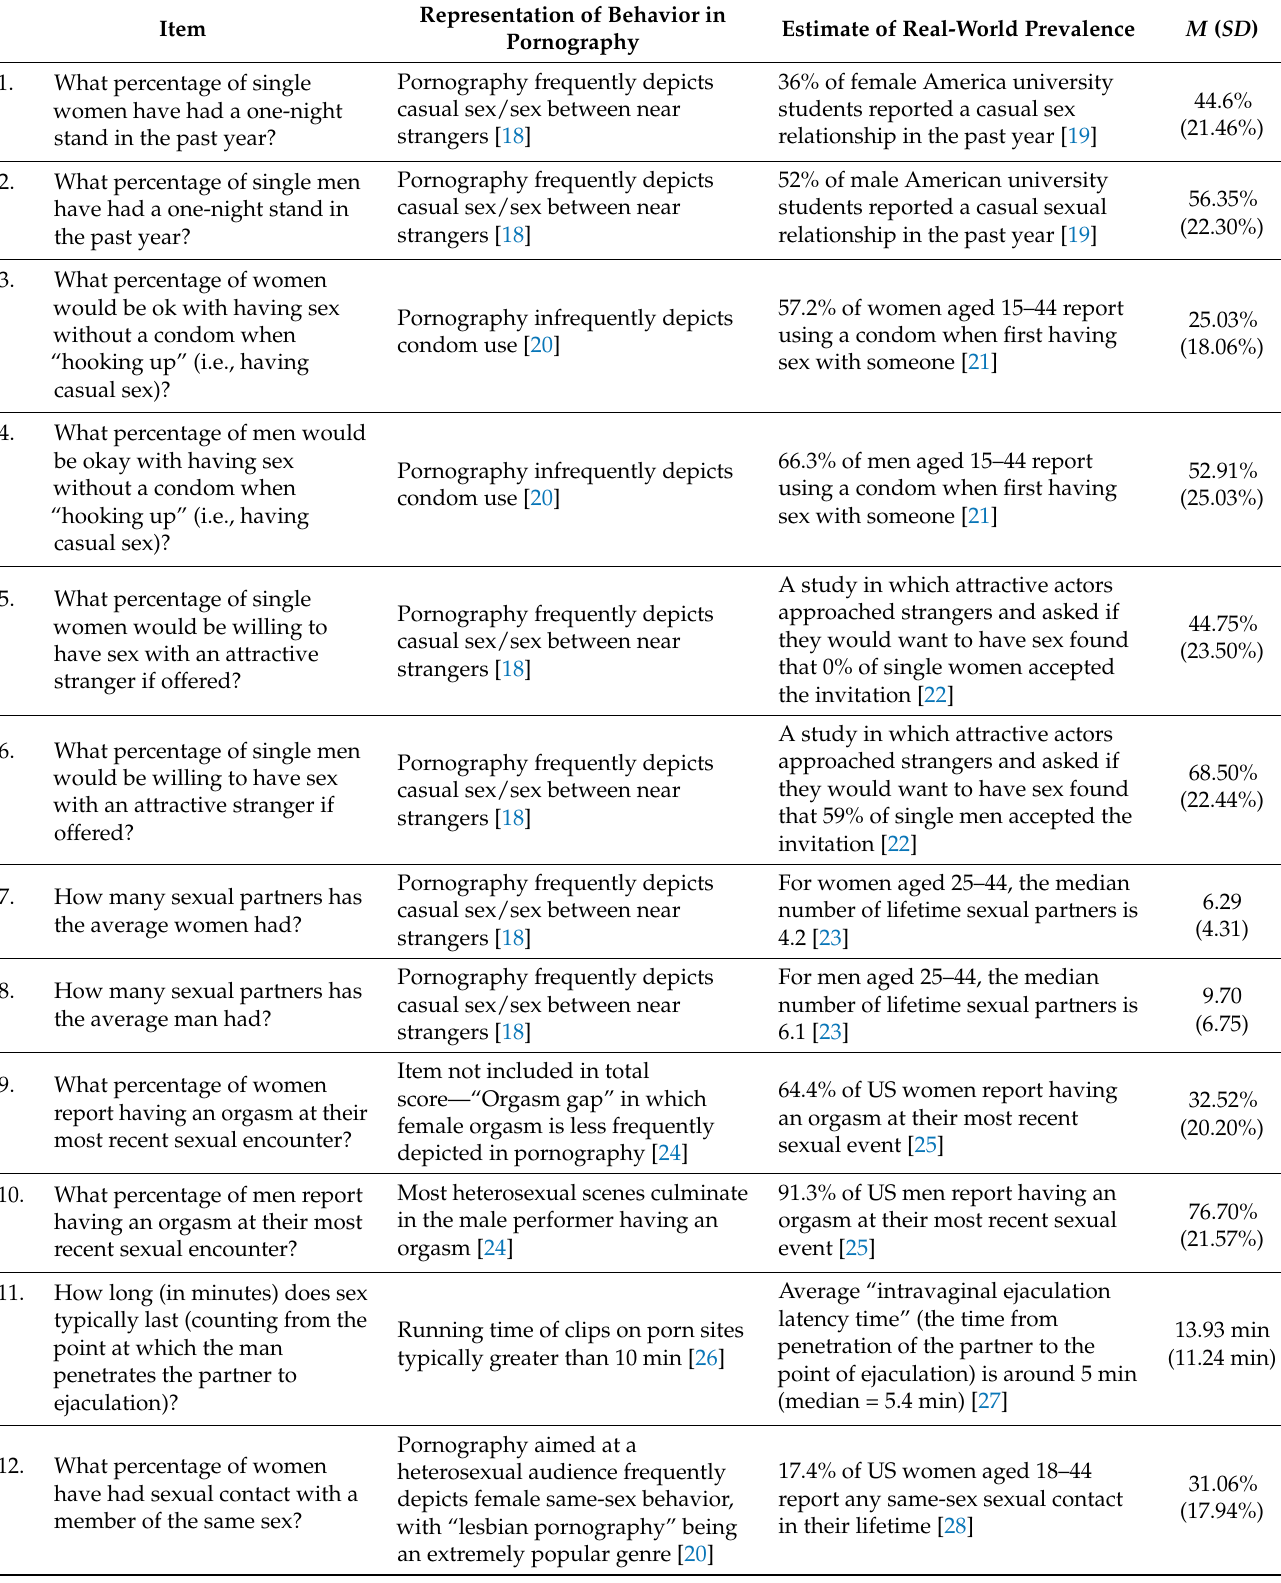
Table 1. Items used to assess porn-congruent sexual health beliefs along with mean ( SD ) response among the